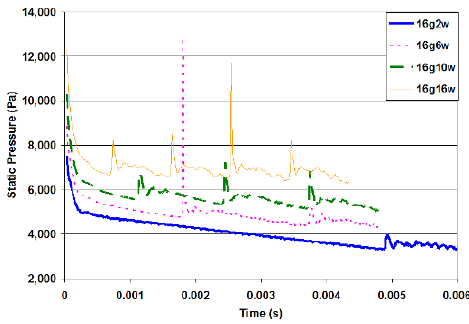
Figure 15. Static pressure fluctuation at air inlet during slug forma- tion at T-junction